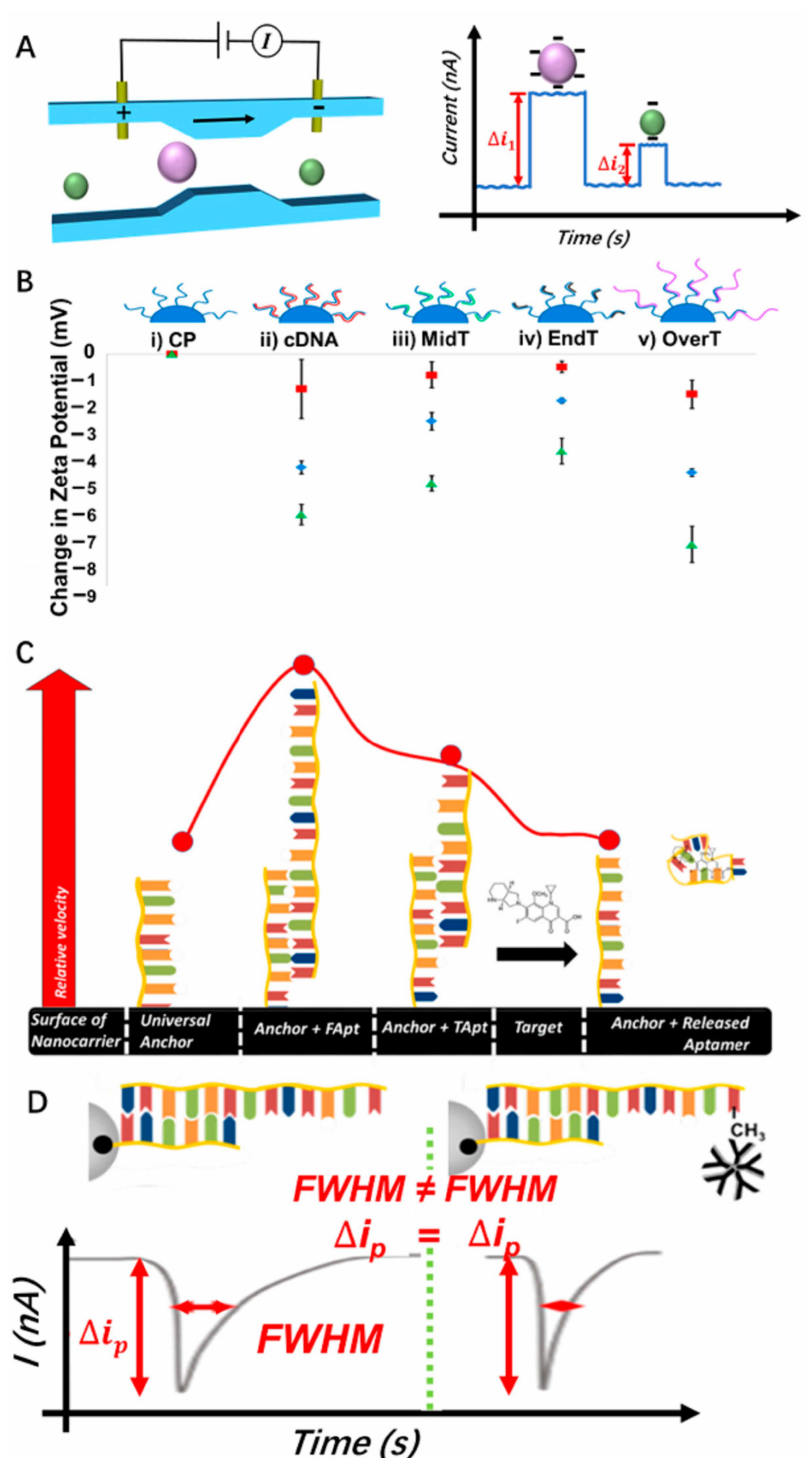
Figure 9. RPS—aptasensors based on an aptamer capture assay. ( A ) Schematic of the resistive pulse setup. ( B ) Schematic of different kinds of CS-conjugated aptamers via different binding positions and lengths, reproduced with permission from [94]. Copyright 2016 American Chemical